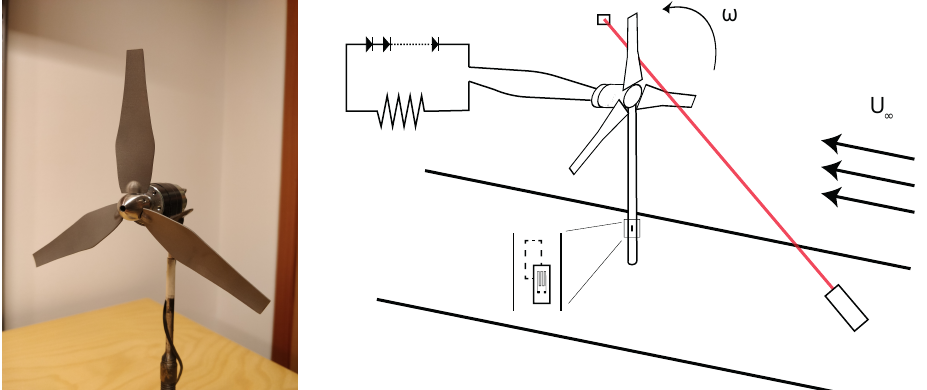
Figure 3. Turbine model ( left ) and schematic of the setup ( right ). Highlighted here are the external circuit connected to the DC generator, the strain gauges, and the laser diode